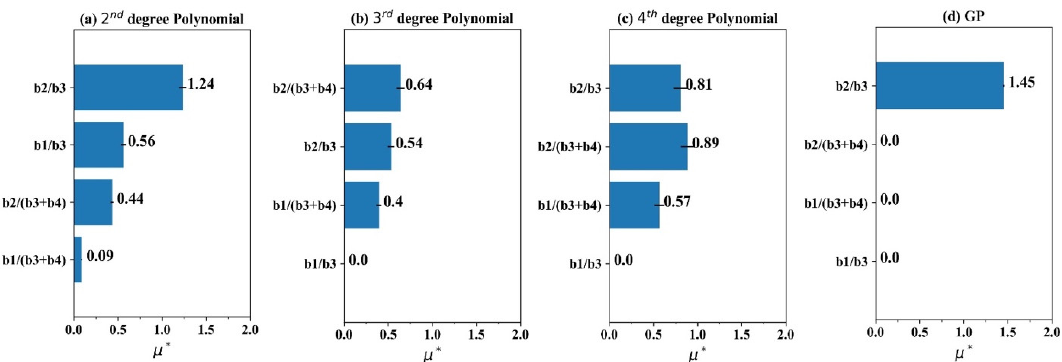
Figure 10. Sensitivity measure index ( μ * ) for the winter day (2016.2.2); ( a ) 2 nd -degree MPR, ( b ) 3 rd -degree MPR, ( c ) 4 th -degree MPR, and ( d ) GP. Note that the higher values of μ * for a given parameter indicate higher sensitivity of the model to the changes of the parameter.